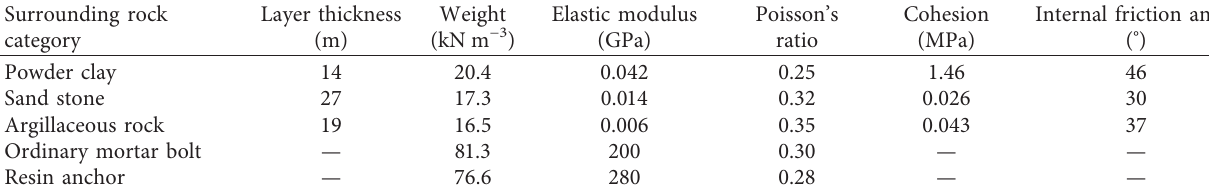
Table 2: Physical and mechanical parameters of rock mass.